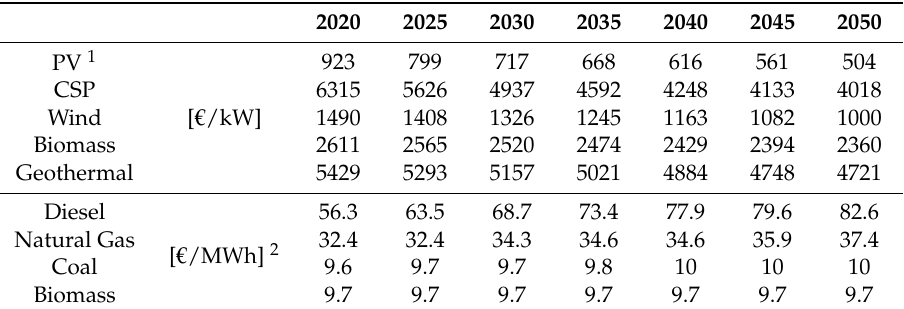
Table A1. Projected investment costs of renewable generation and of